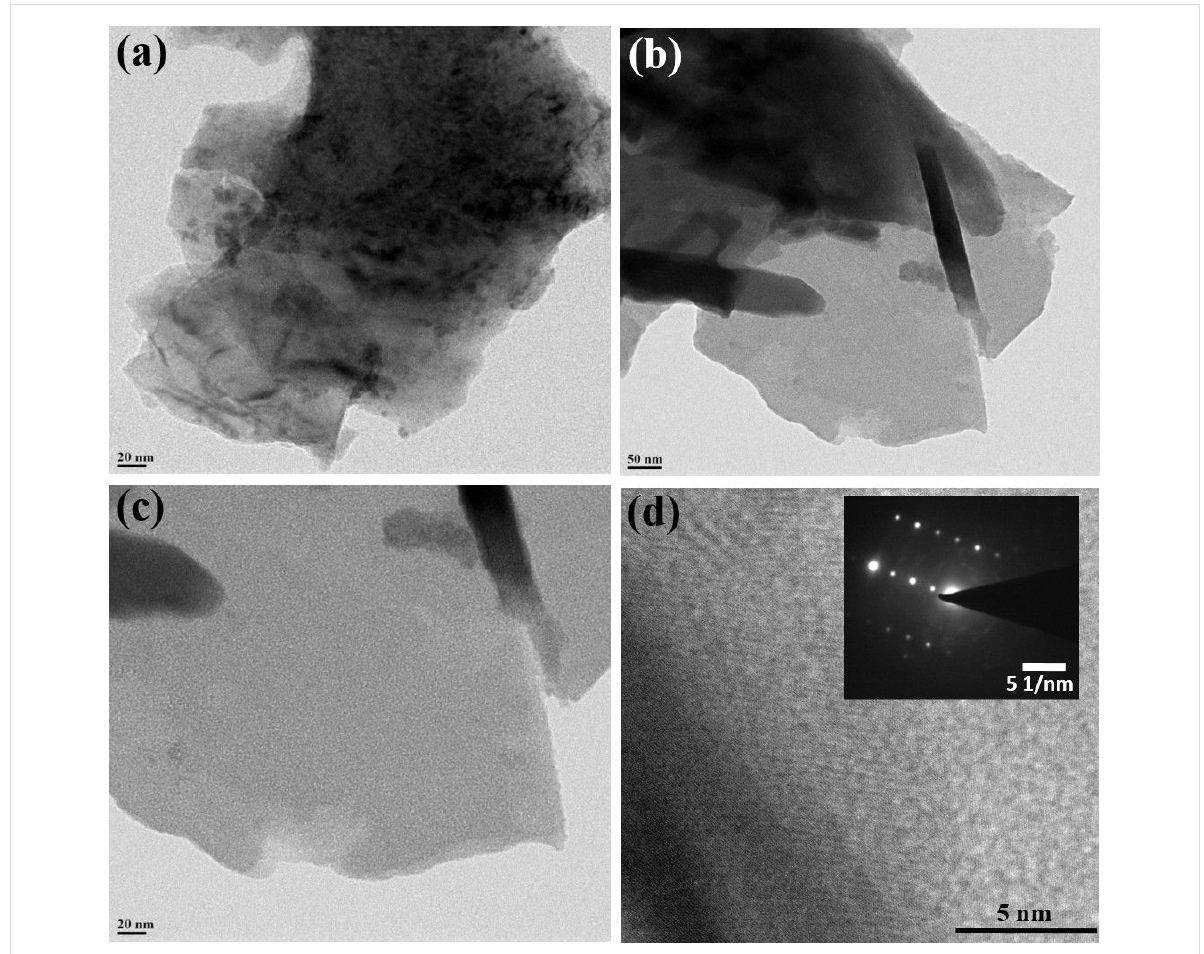
Figure 3: (a–c) Low-magnification TEM images and (d) a high-magnification TEM image, where the inset shows the selected area electron diffraction (SAED) pattern for the as-synthesized PtSe 2 nanosheets.